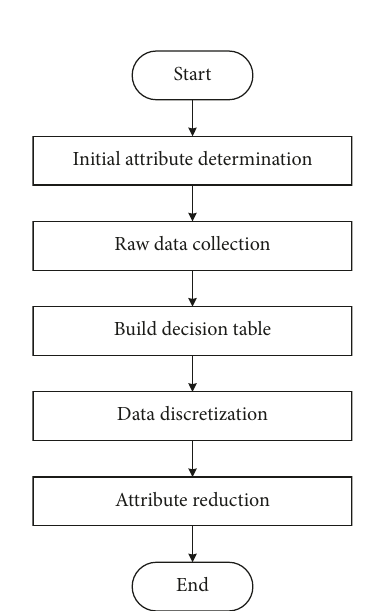
Figure 3: Construction process of prediction attribute reduction model based on rough